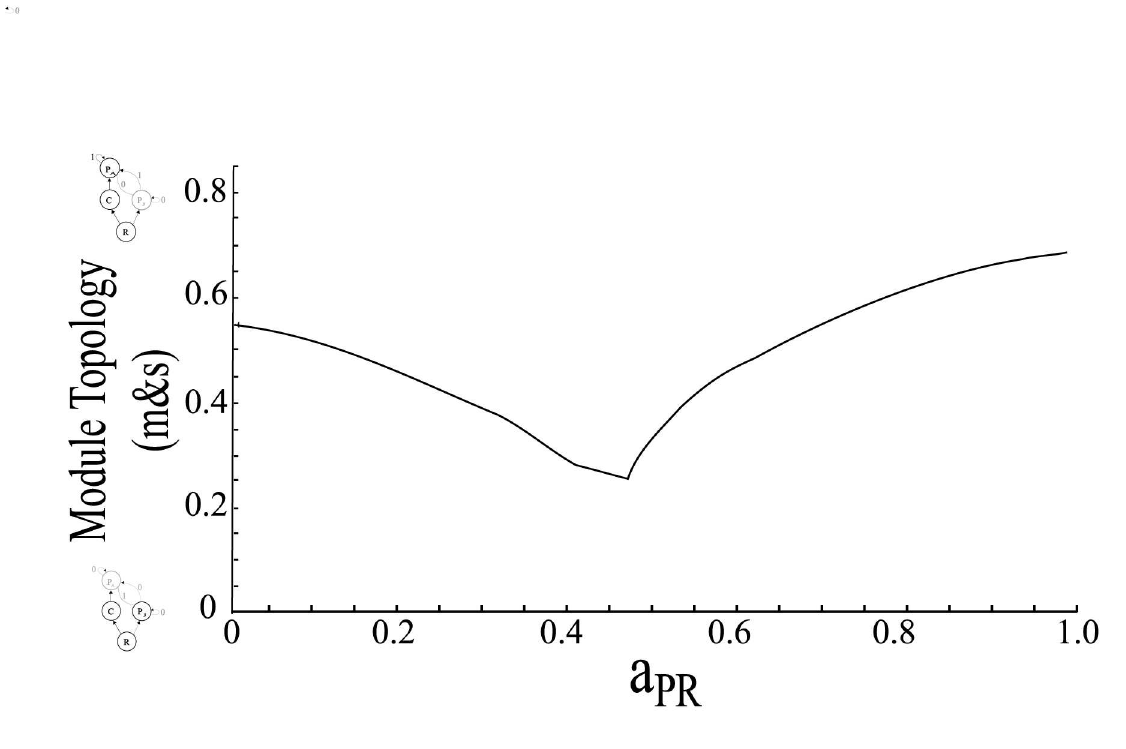
Fig 4. Maximum stability of the LHIGP module. Patterns of the maximum point of stability reachedacross nested food-web modulesover a range of juvenilepredator consumption constants for Case 1, which is representative of the qualitative patterns for all four cases (Parameter values: r = 1.5, K = 1, a CR = 3, a PC = 1, a PR = 0–1, b CR = 1.5, b PC = 1, b PR = 1 , d C = 0.5, d P = 0.15).